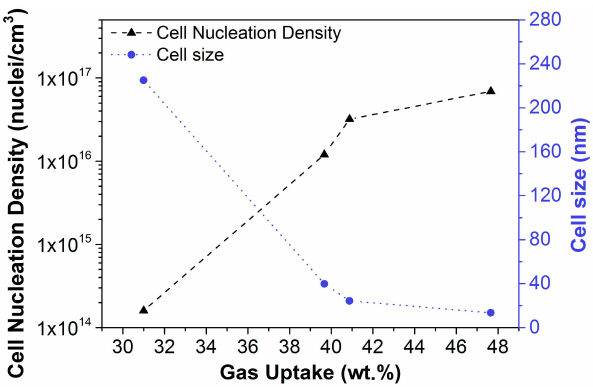
Figure 1. Cell nucleation density (left axis) and cell size (right axis) as a function of the solubility for homogeneous polymethylmethacrylate (PMMA).